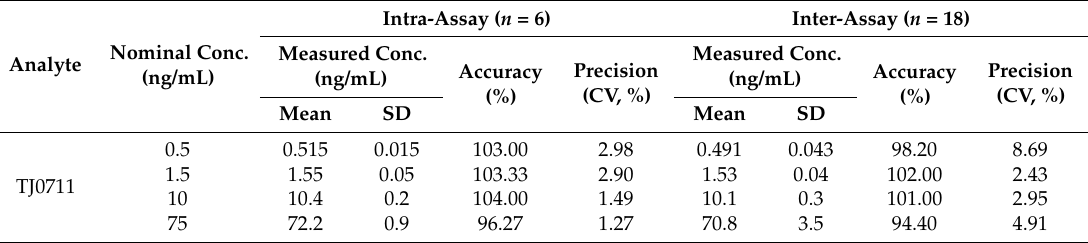
Table 2. Intra-assay and inter-assay accuracy and precision summary of analytes in dog